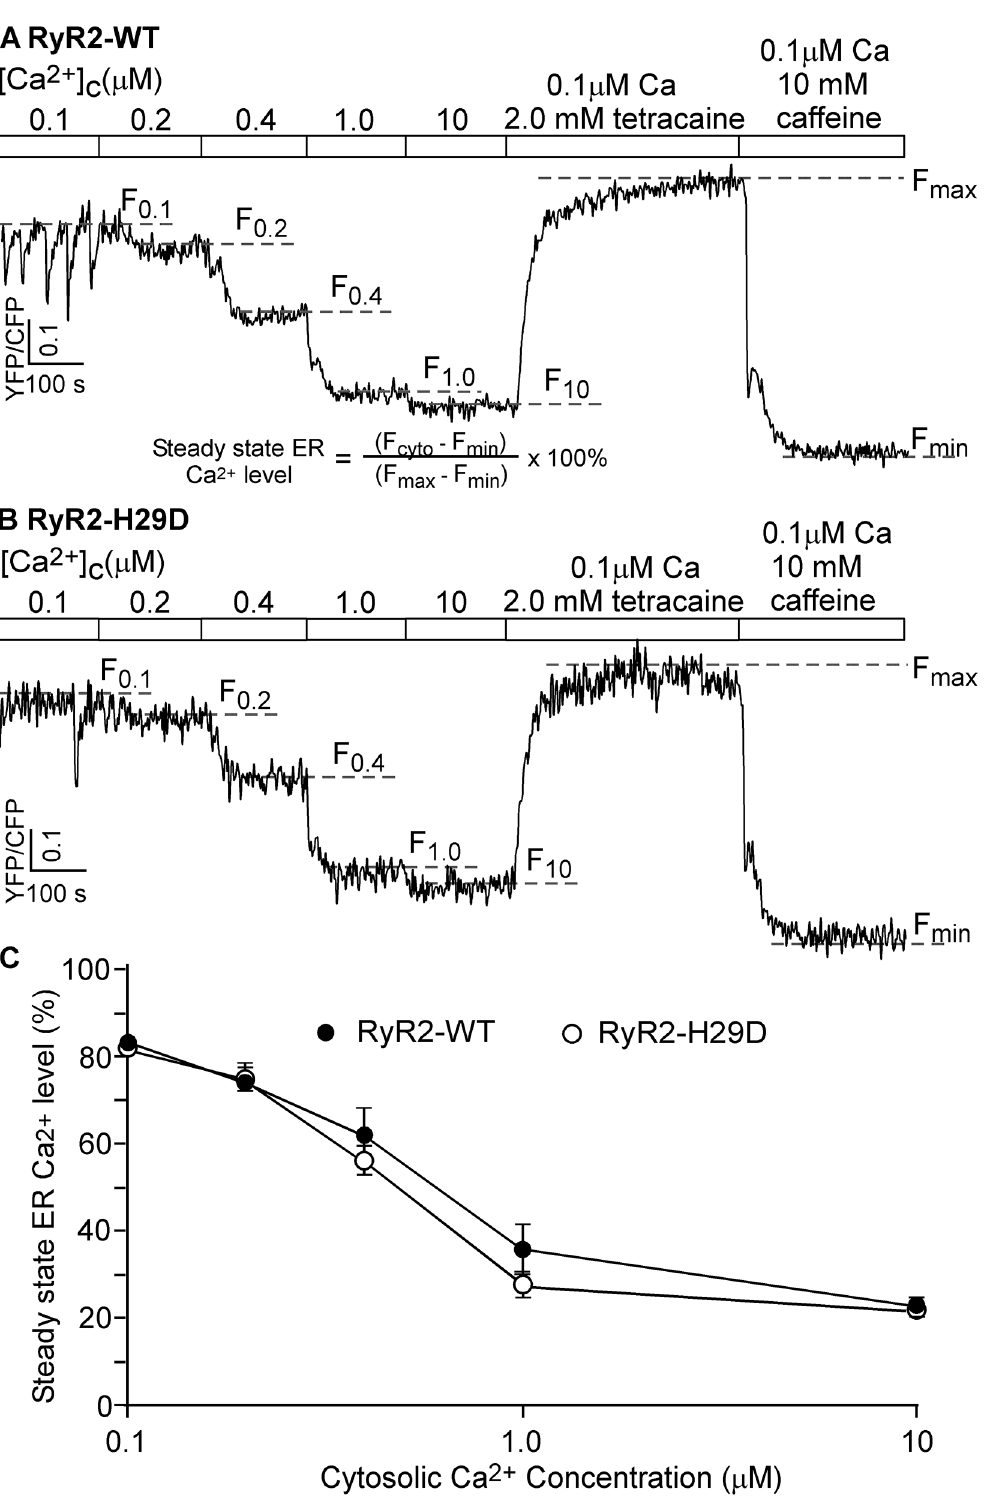
Fig 3. Effect of the H29D mutation on cytosolic Ca 2+ induced Ca 2+ release in HEK293 cells. Stable, inducible HEK293 cell lines expressing RyR2 WT (A) or the H29D mutant (B) were transfected with the FRET-based ER luminal Ca 2+ -sensing protein D1ER and their expression were induced using tetracycline. The transfected and induced cells were permeabilized with saponin, washed and perfused with intracellular-like medium plus increasing levels of free cytosolic Ca 2+ (0.1, 0.2, 0.4, 1.0 and 10 μ M) to induce Ca 2+ release. FRET recordings from representative cells (total 51 – 93 cells each) are shown. To